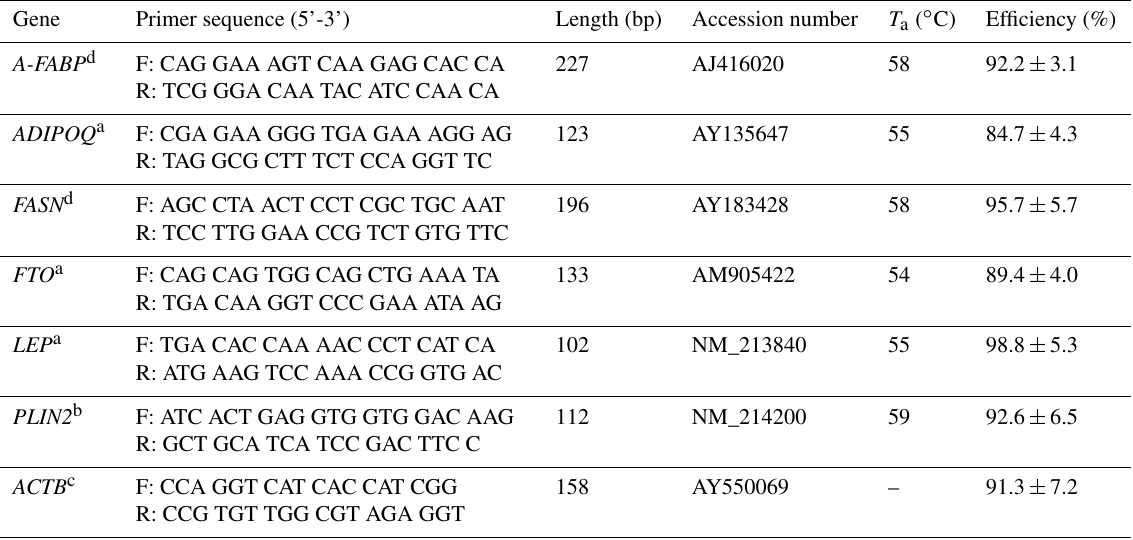
Table 2. Primer sequences, length of PCR products, gene accession numbers, annealing temperatures ( T a ), and PCR efficiency (mean ± SD) Gene Primer sequence (5’-3’)